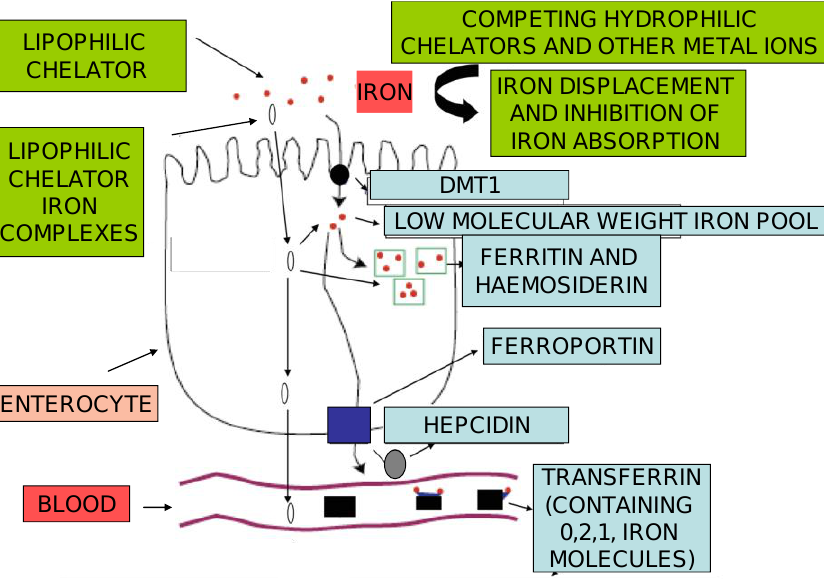
Figure 1. Mechanisms of iron absorption at the enterocyte. Animated image of the regulatory pathways involved in iron absorption. Iron metabolic pathways involving the apical divalent metal transported protein (DMT1), ferritin, hepcidin, ferroportin, and transferrin. A parallel, non- regulatory iron absorption pathway is also shown using lipophilic iron chelator complexes. In contrast to lipophilic chelators, hydrophilic chelators appear to inhibit iron absorption. The initial step of the mechanism in the regulatory pathway of iron absorption is thought to involve the reduction of dietary ferric iron to ferrous iron by a ferrireductase at the surface of the enterocyte before its intracellular transport by DMT1 (Figure 1) [1–4]. Following intracellular entry in the enterocyte, iron is partly incorporated into ferritin or transferred into the low molecular weight, intracellular iron pool. In subsequent steps, iron is transported to ferroportin at the basolateral membrane of the enterocyte, which then exports it in plasma, where it is bound by transferrin. Iron bound by transferrin is then transferred to all of the cells of the body via an uptake mechanism by transferrin receptors present at the cell surface, followed by intracellular dissociation of iron from transferrin in an endosome of acidic pH